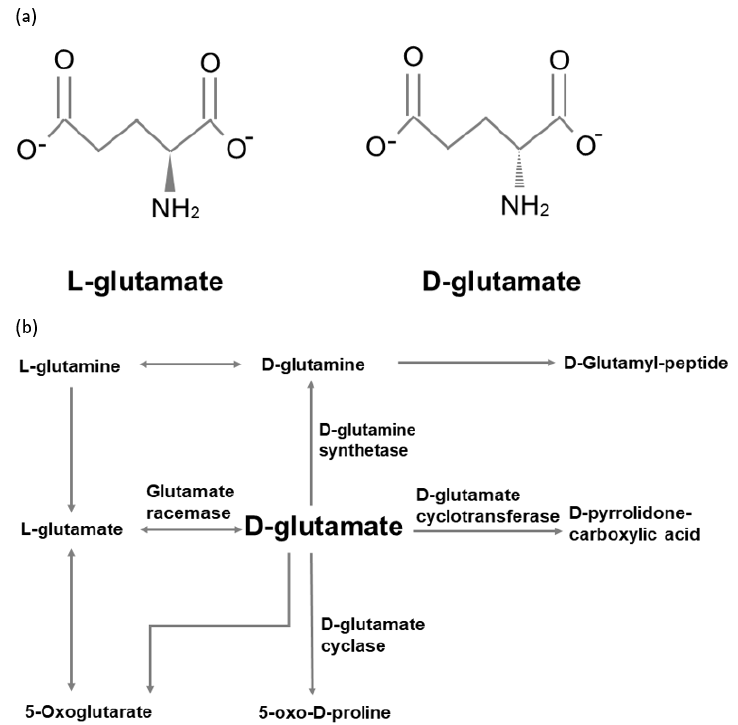
Figure 1. ( a ) L -glutamate and D -glutamate. ( b ) D -glutamate metabolic pathways. Figure 1. ( a ) l -glutamate and d -glutamate. ( b ) d -glutamate metabolic